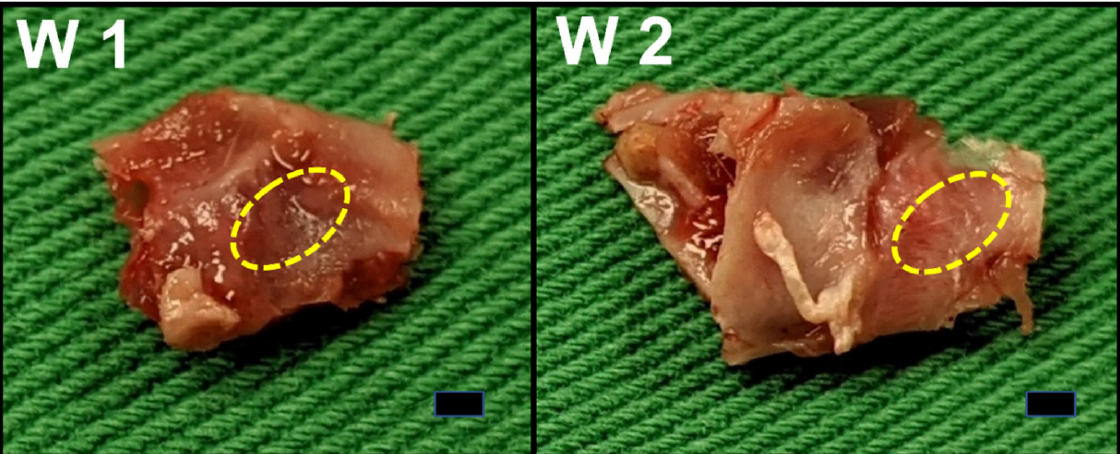
Figure 13. The gross view of bone formation in the cavity (yellow-dotted) at postoperative day 7 ( left ) and day 14 ( right ) (Scale bar = 1 mm).